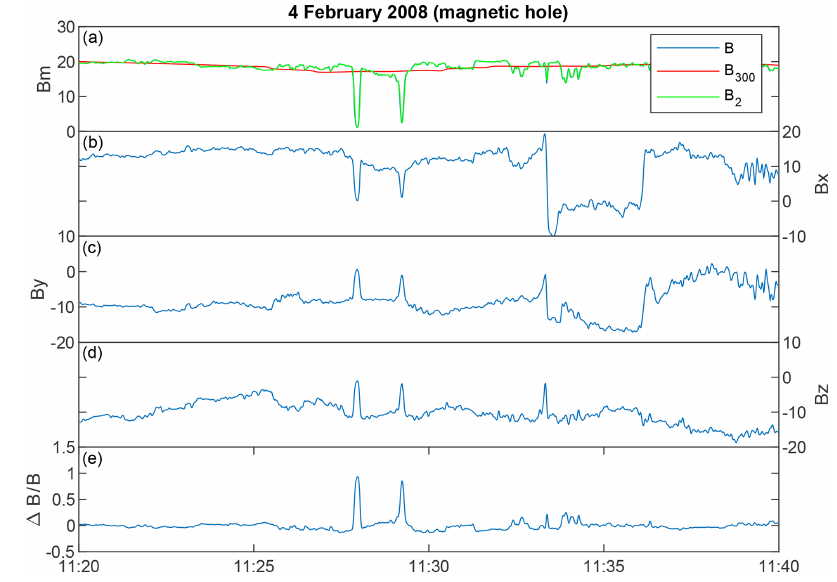
Figure 3. Two magnetic holes on 4 February 2008 between 11:25 and 11:30UT with rotation over the structure (cid:50) < 10 ◦ and depth (cid:49)B/B 300 > 0 . 8. Panel (a) shows the magnetic field magnitude full resolution (blue), B 300 (red), and B 2 (green). Panels (b) – (d) show the unfiltered magnetic field components B x , B y , and B z . Panel (e) shows the (cid:49)B/B 300 . Note that this time interval would count as one event even though two holes can be seen, which have a separation of ∼ 2min.